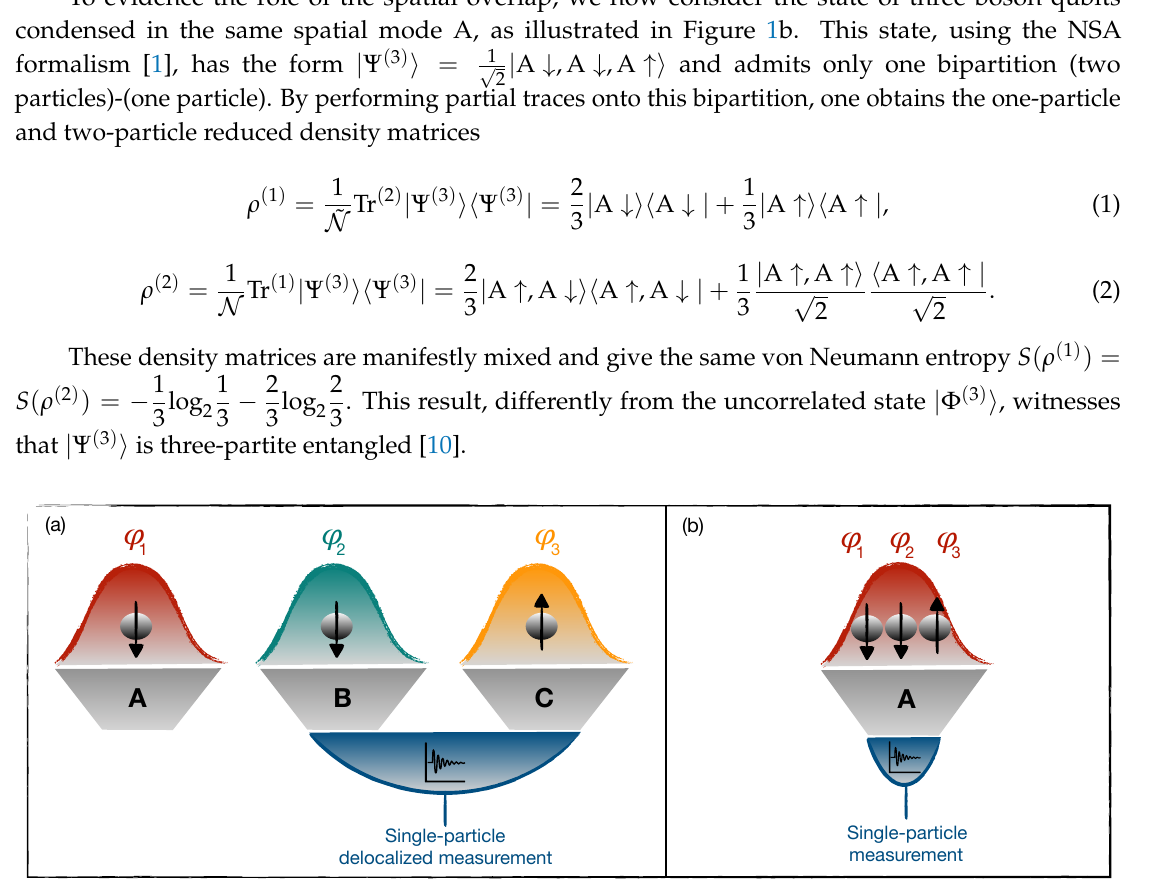
Figure 1. ( a ) Configuration of the state | Φ ( 3 ) (cid:105) when particles are in separated spatial regions (grey zones). ( b ) Complete spatial overlap of three qubits in the spatial region